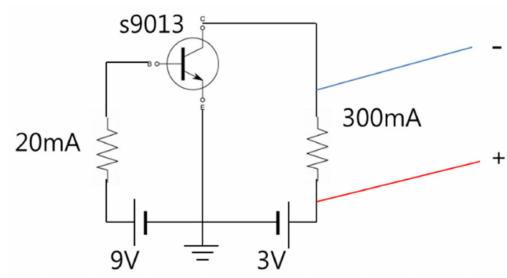
Figure 18. Experimental setup.